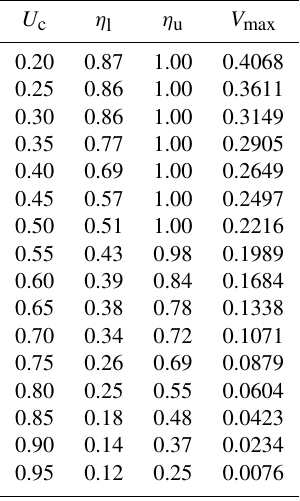
Table 1. Values of η l , η u , and V max for various U c